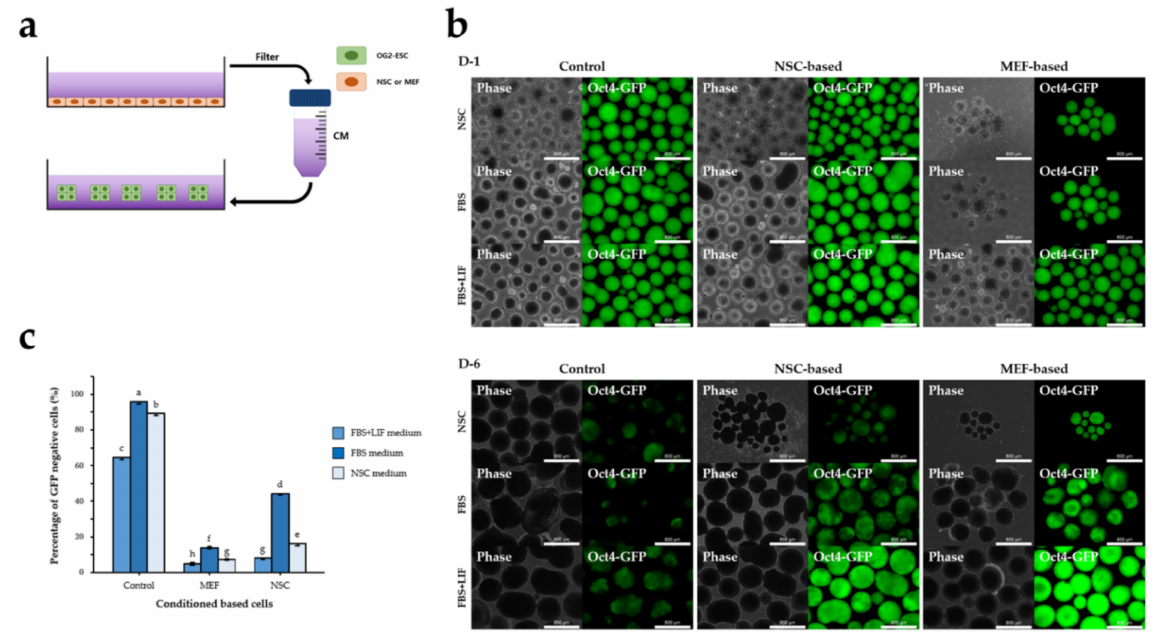
Figure 3. OG2-ESC cultured with CM under 3D condition. ( a ) CM prepared from the NSCs after 72 h in culture and used in the 3D culture of undifferentiated ESCs. ( b ) Day 1 and day 6 phase and fluorescence (GFP) images of 3D OG2-ESCs cultured in non-conditioned medium or NSC- or MEF-based conditioned FBS, FBS + LIF, and NSC medium for 6 days. Scale bar = 800 µ m. ( c )